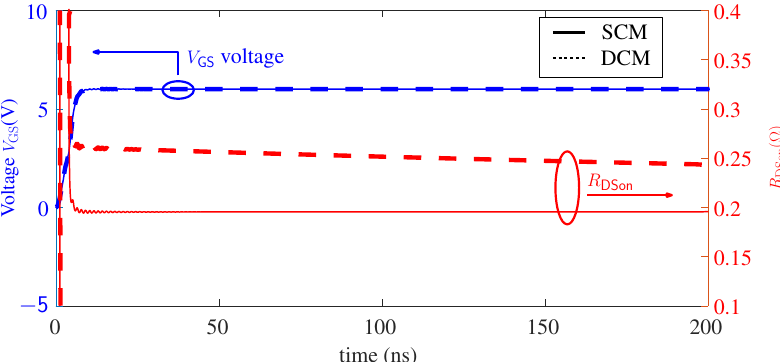
Figure 12. Comparison between GaN-HEMT SCM and DCM for dynamic R DSon